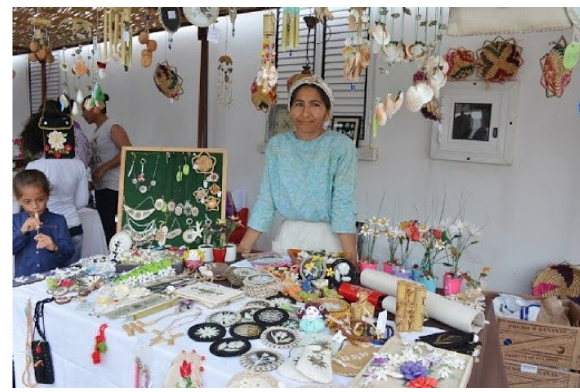
Fig. 6 Komikebir village eco-day activity. Komikebir-craft